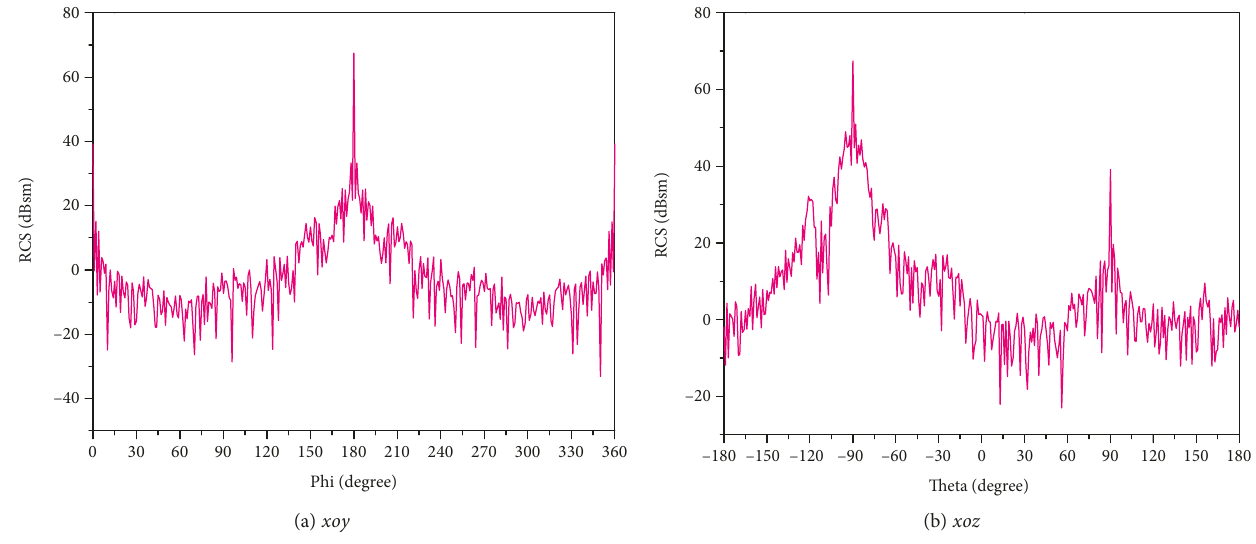
Figure 15: Bistatic RSC of the aircraft at 33